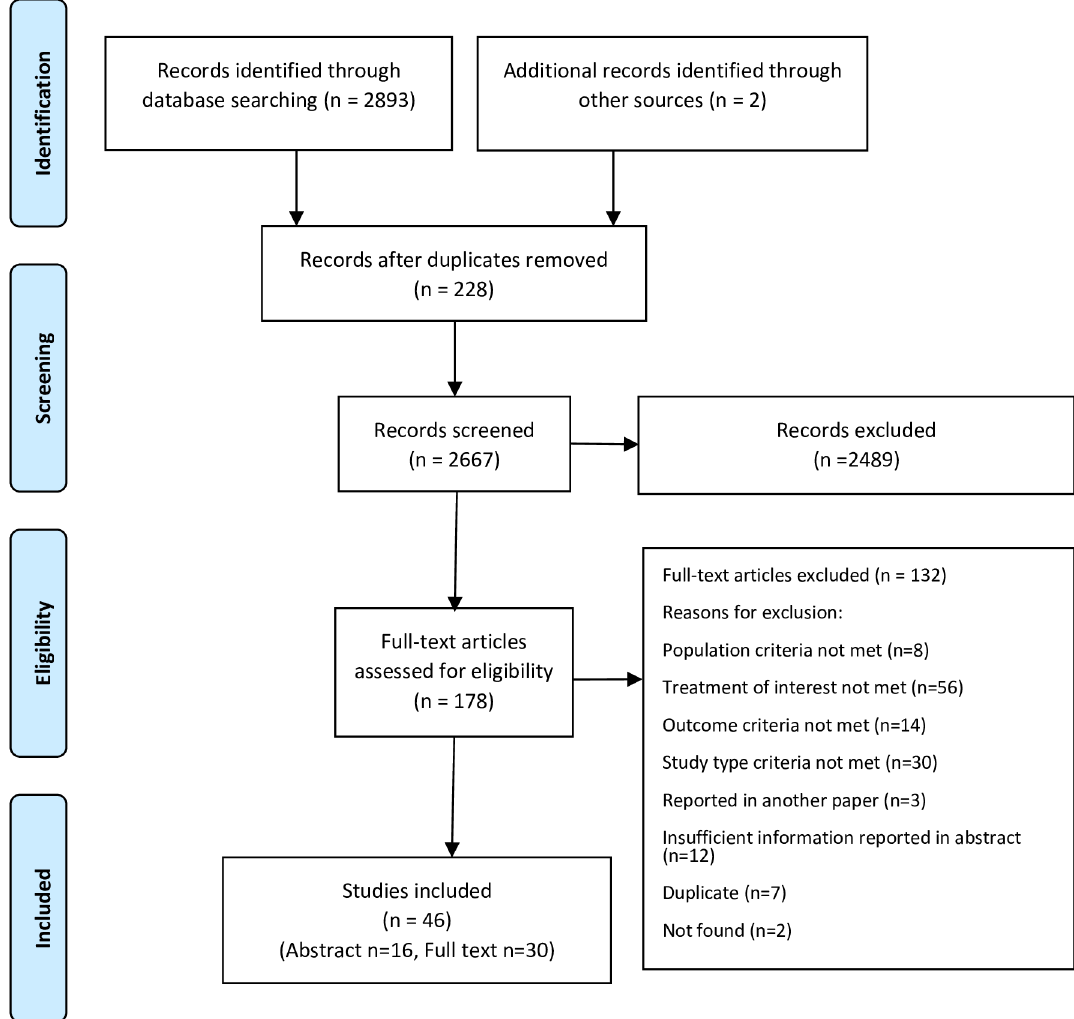
Fig 1. PRISMA flow diagram of study